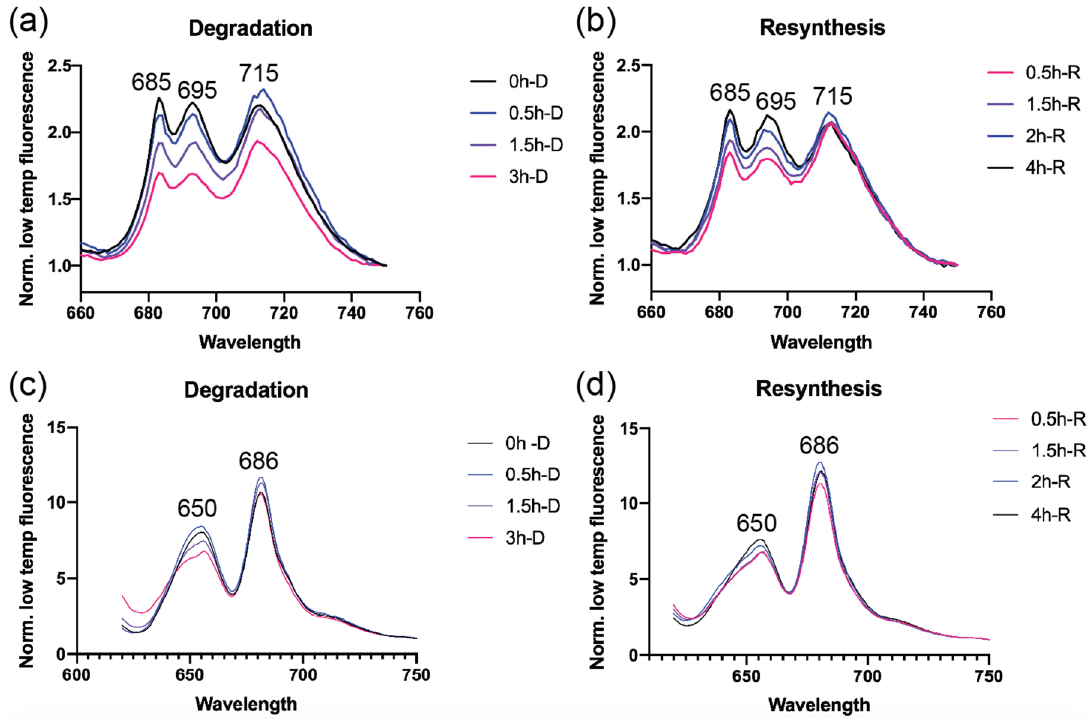
Figure 2. Low temperature (77 K) fluorescence emission spectra of UTEX 2973 with excitation at 435 nm for Chl ( a , b ) and at 600 nm for phycobilins ( c , d ) taken at di ff erent time points during N depletion and repletion. Fluorescence intensities are normalized at 750 nm to highlight di ff erences in the intensities at PSI, PSII, and PC peaks. Peaks are labeled corresponding to the description in the text. Spectra shown are representative data from three independent biological replicates ( n = 3).